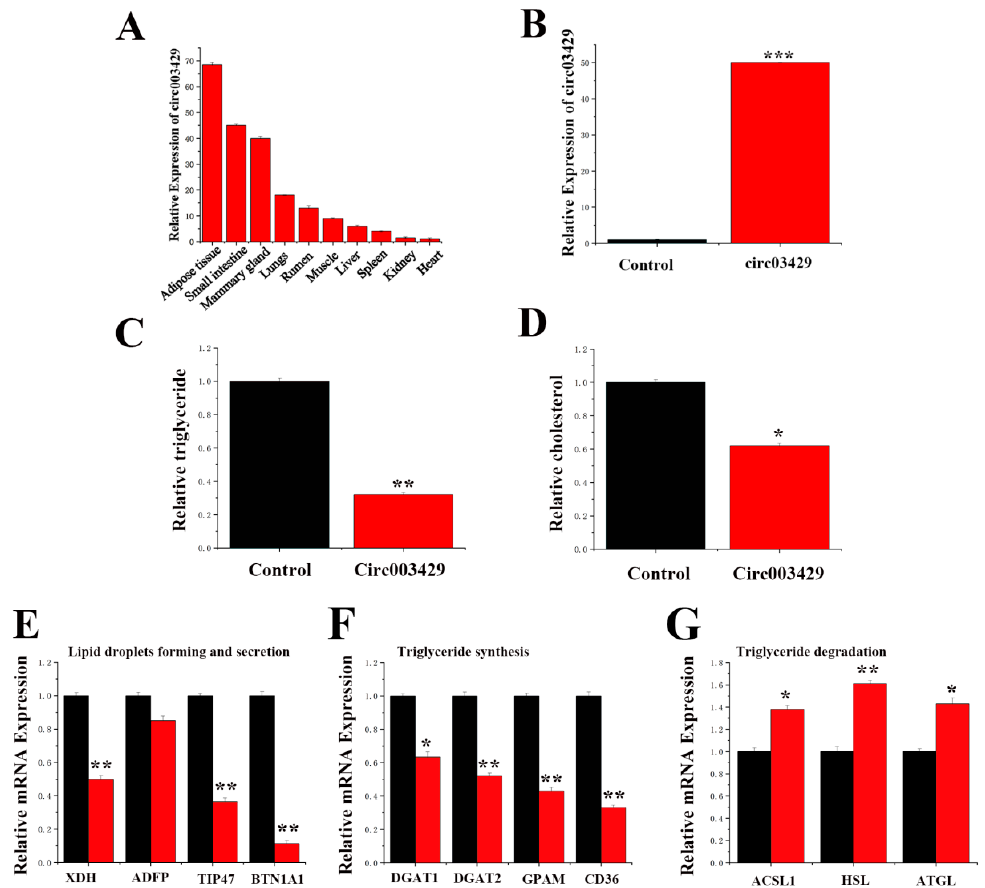
Figure 7. Functional verification of circ003429 in GMECs. ( A ) Tissue specific expression analysis of circ003429. ( B ) Expression efficiency of the circ003429 overexpression vector (pcDNA-circ003429). ( C ) Relative TAG levels. ( D ) Relative cholesterol levels. ( E – G ) Effects of circ003429 on genes related to lipid deposition and secretion in goat mammary epithelial cells. Black bars represent the negative control, and red bars represent circ003429. Values are shown as the means ± standard errors. * p < 0.05; ** p <0.01; *** p < 0.001.